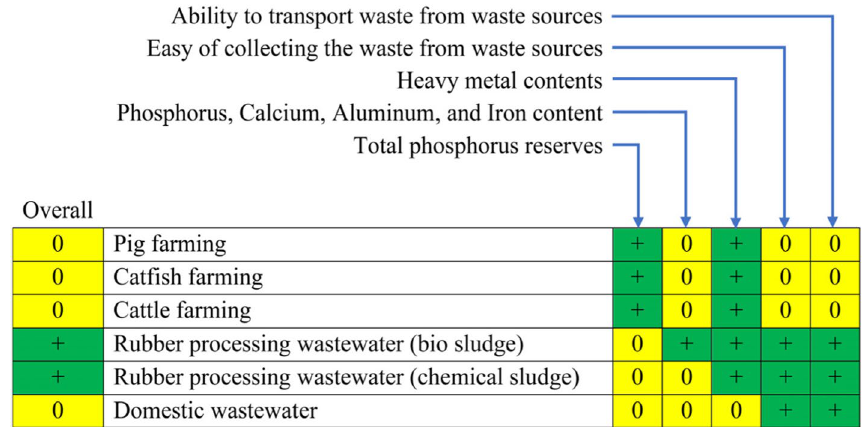
Fig. 8 General cascade option tree for potential waste resources is